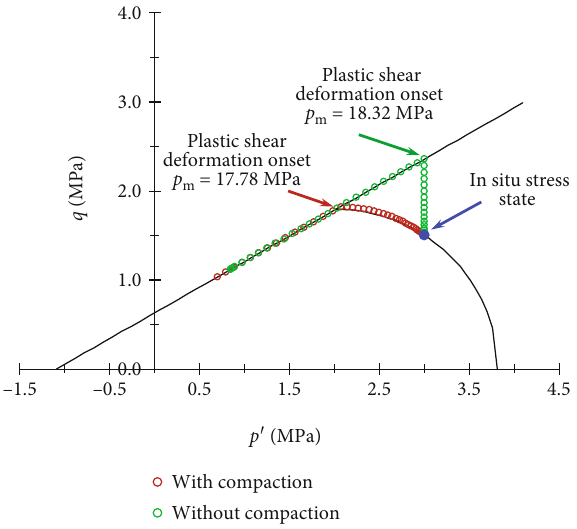
Figure 5: E ff ective stress paths experienced by a point on the wellbore surface during the drilling process (perfect fl ow barrier and p m of 16.94